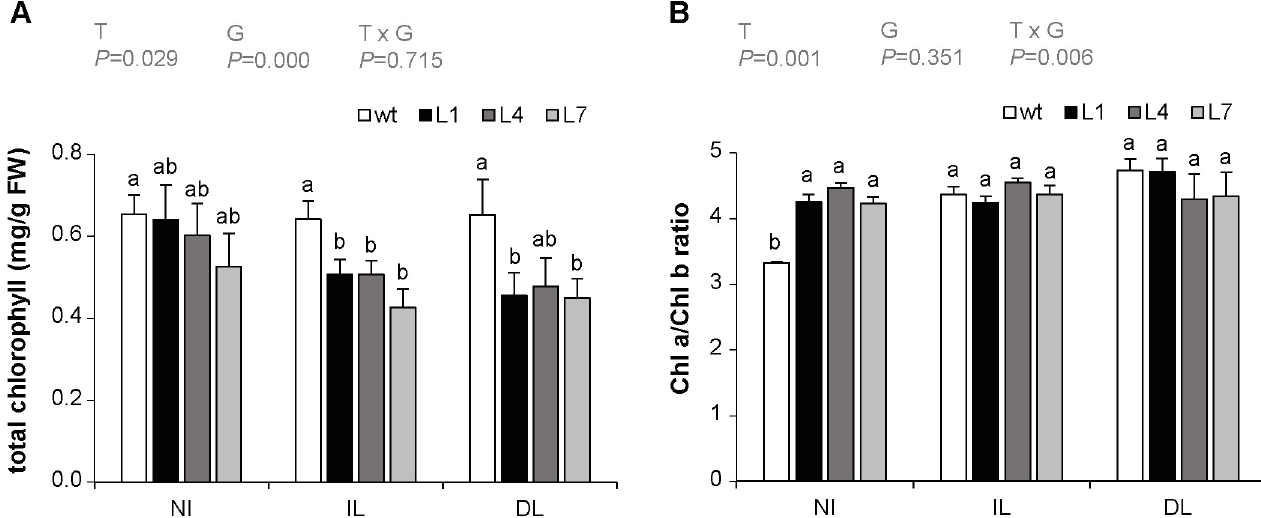
Fig 5. Changes in chlorophyll content in response to P . infestans infection. Wild type (wt) and PP2Ac2b-OE (L1, L4 and L7) plants were inoculated with P . infestans as described in Materials and Methods. Leaves from non-infected plants (NI), infected leaves (IL) and distal leaves (DL) were collected after four dpi for chlorophyll measurement. (A) Total chlorophyll content. (B) Ratio between chlorophyll a and chlorophyll b. Data are the mean ± SEM of of three independent experiments. Data were analyzed by two-way ANOVA, followed by Bonferroni post-hoc test ( α = 0.05) comparing the total chlorophyll content or the Chl a/Chl b ratio for each line (wt, L1, L4 or L7) among NI, IL and DL, and the total chlorophyll content or the Chl a/Chl b ratio among the different lines within each experimental condition (NI, IL or DL). P -values of the effect of treatment (T: NI, IL, DL), genotype (G: wt, L1, L4, L7) and their interaction are shown. The two-way ANOVA showed a significant interaction between the effects of T and G on the Chl a/Chl b ratio (B). There was a significant effect of T on total chlorophyll and the Chl a/Chl b ratio (A; B), and a significant effect of G on total chlorophyll